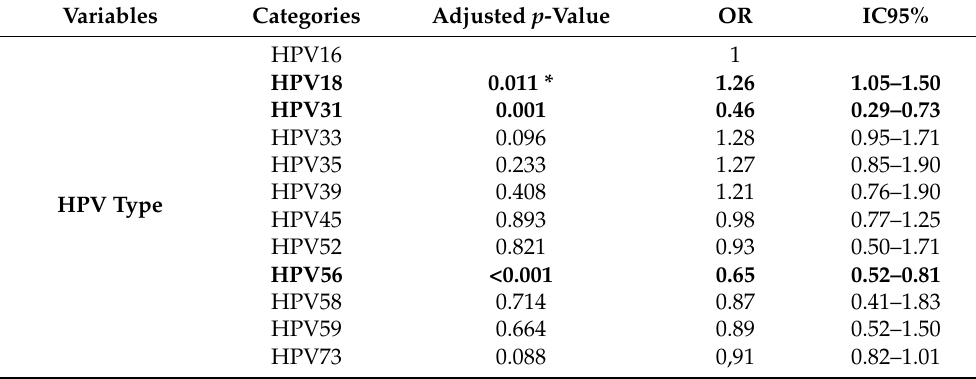
Table 2. Multivariate analysis for the association of APOBEC3B expression levels with HPV type, histological type and clinical staging at diagnosis in women with cervical cancer from